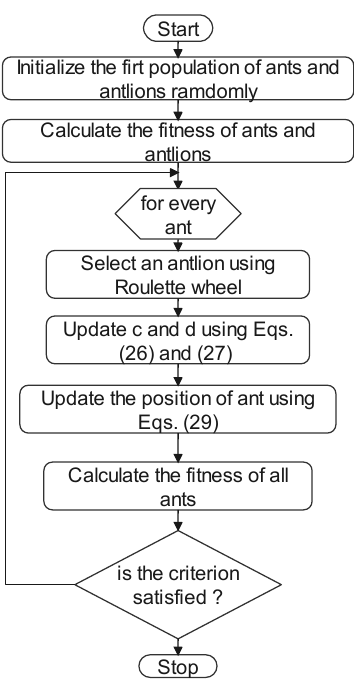
Figure 7. Flow chart of the ant lion optimizer. The random movements of ants in the search space are affected by the antlion’s traps. Equations (24) and (25) are used to model this [42]. Here, the indices i , j , and t indicate the number of ants, the number of antlions, and the number of iterations, respectively. C is the minimum value of the variables and d is the maximum value of the